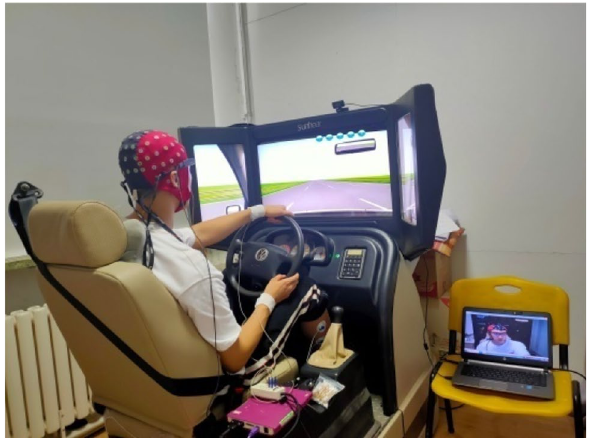
Figure 1. Automated driving scenario in the Sunheart QJ-3A1 Driving Simulator